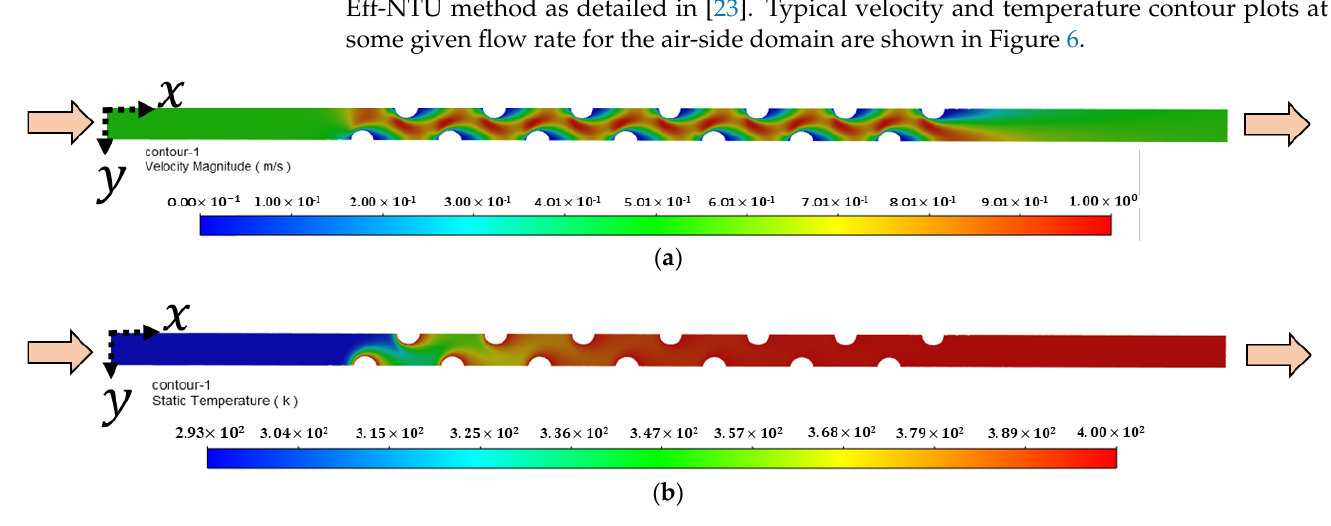
Figure 6. Contour plots of ( a ) velocity and ( b ) temperature for some particular flow-rate at symmetry plane of the air-side domain located distance from the wall.